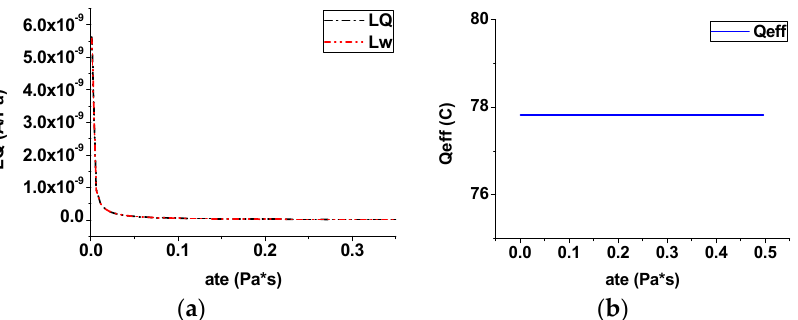
Figure 10. Effect of the viscosity (time-harmonic case): ( a ) streaming current coupling coefficient; ( b ) effective net residual charge density. ( b ) effective net residual charge density.